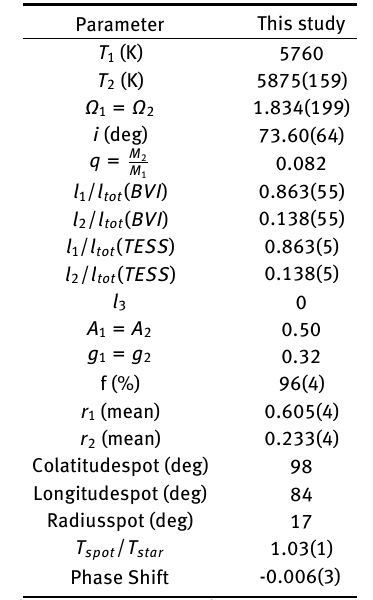
Table 4. Photometric solutions of V870 Ara.